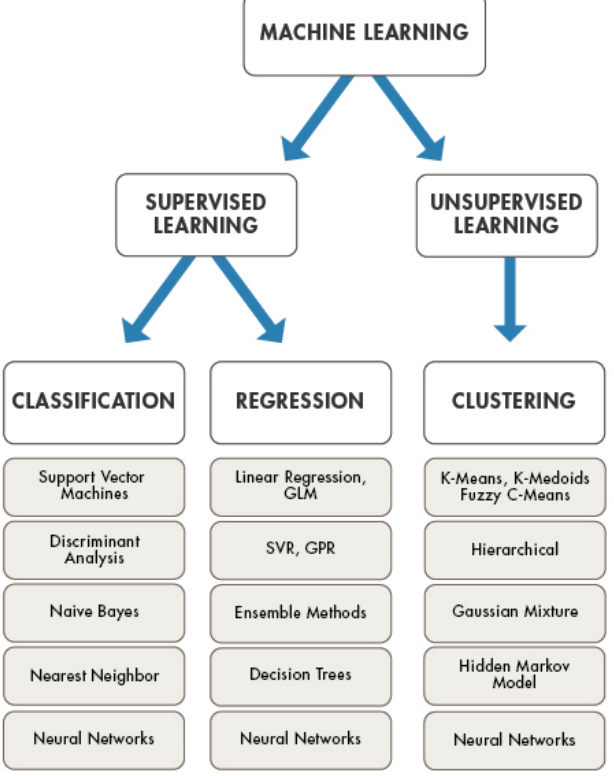
Figure 1. Machine-learning paradigms schematization.